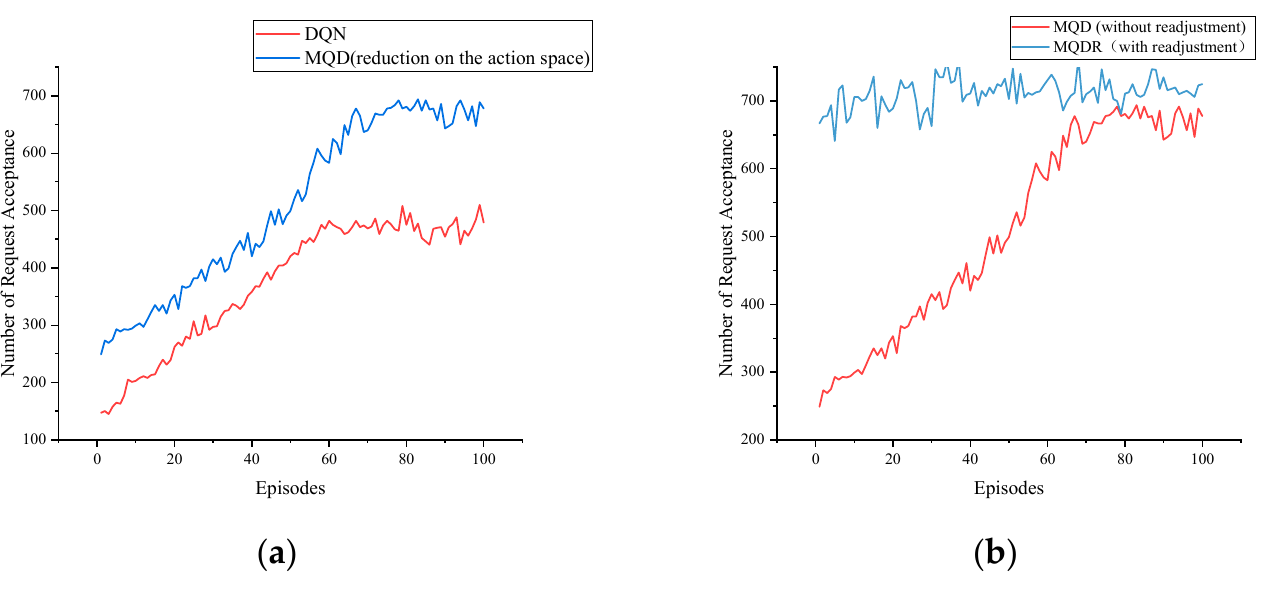
Figure 6. The request acceptance rate of different algorithms.